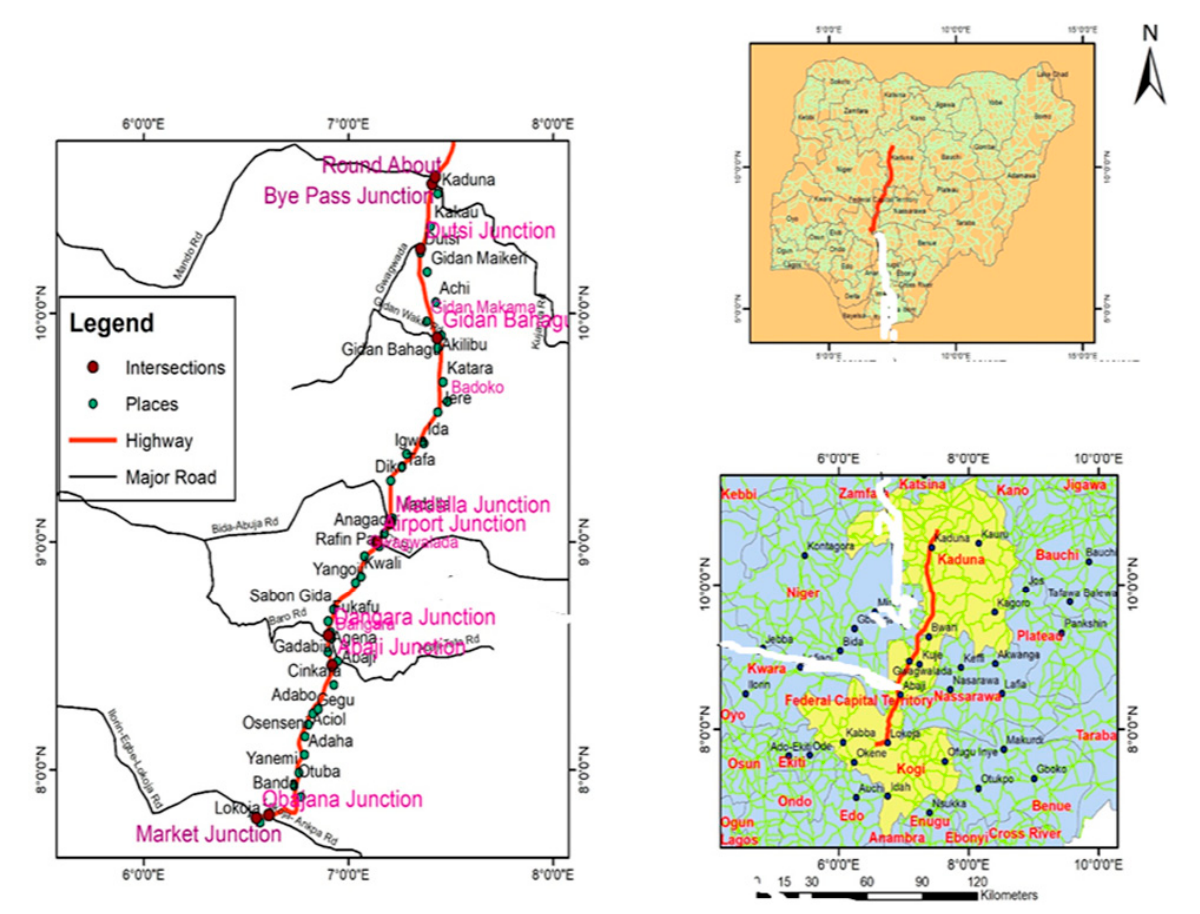
Figure 1. GIS map of the study